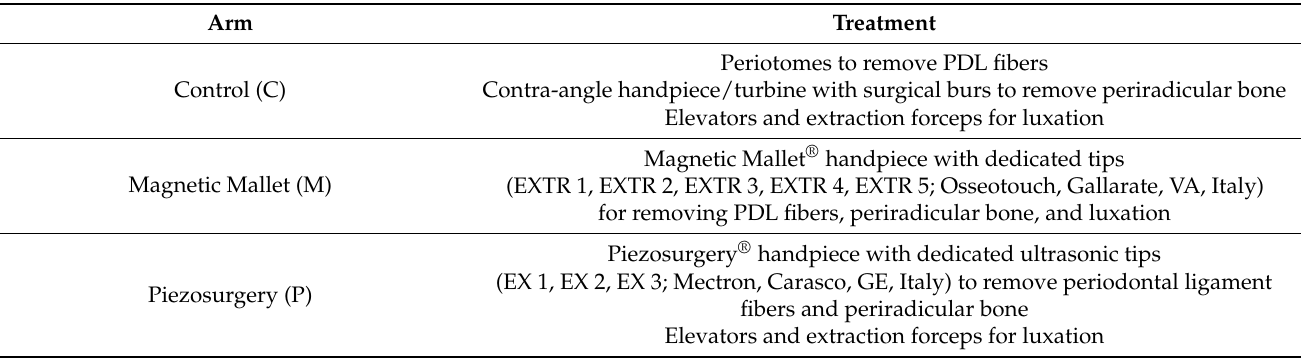
Table 1. Interventions compared in this